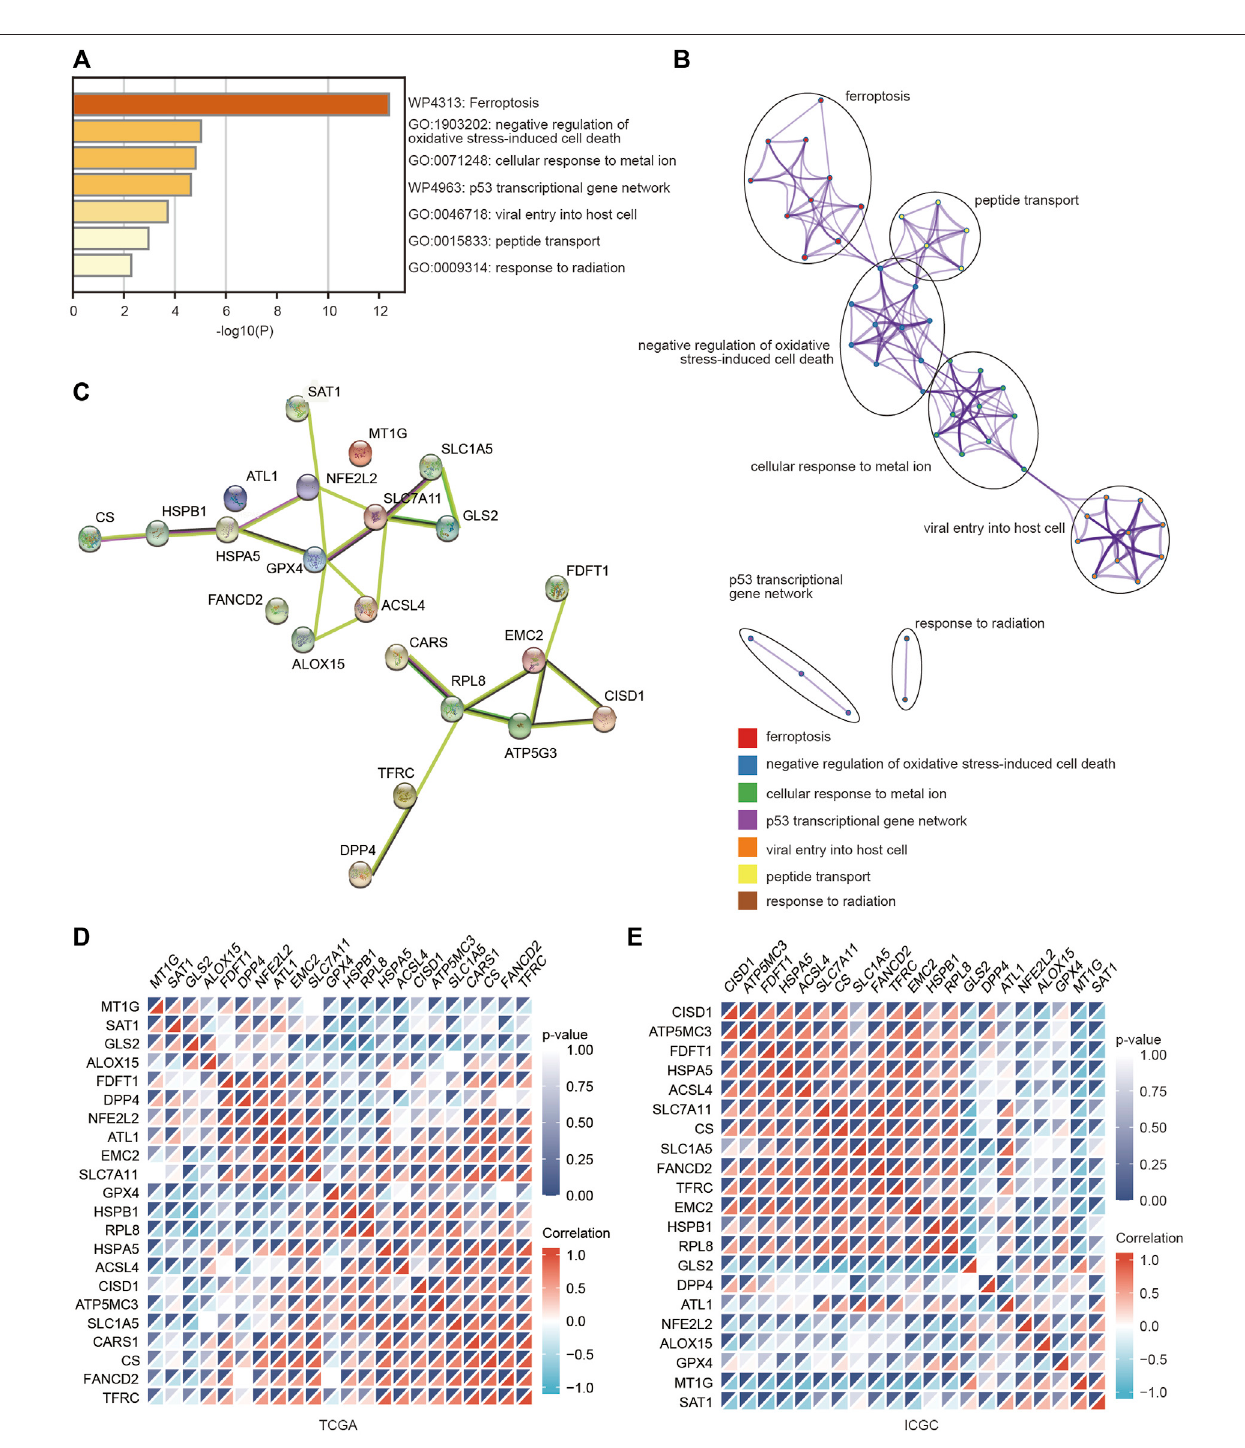
FIGURE 2 | Pathway and functional enrichment analyses of FRGs were performed to explore the role of ferroptosis in HCC. (A) Bar graph summary of FRG- enriched pathways. (B) A PPI network was obtained from the Metascape database. (C) A PPI network was obtained from the STRING database. (D,E) Heatmaps showingthecorrelationsamongtheseFRGsintheTCGAandICGCdatabasesusingthespearmananalysis.Redrepresentsapositivecorrelationandbluerepresentsa negative correlation.